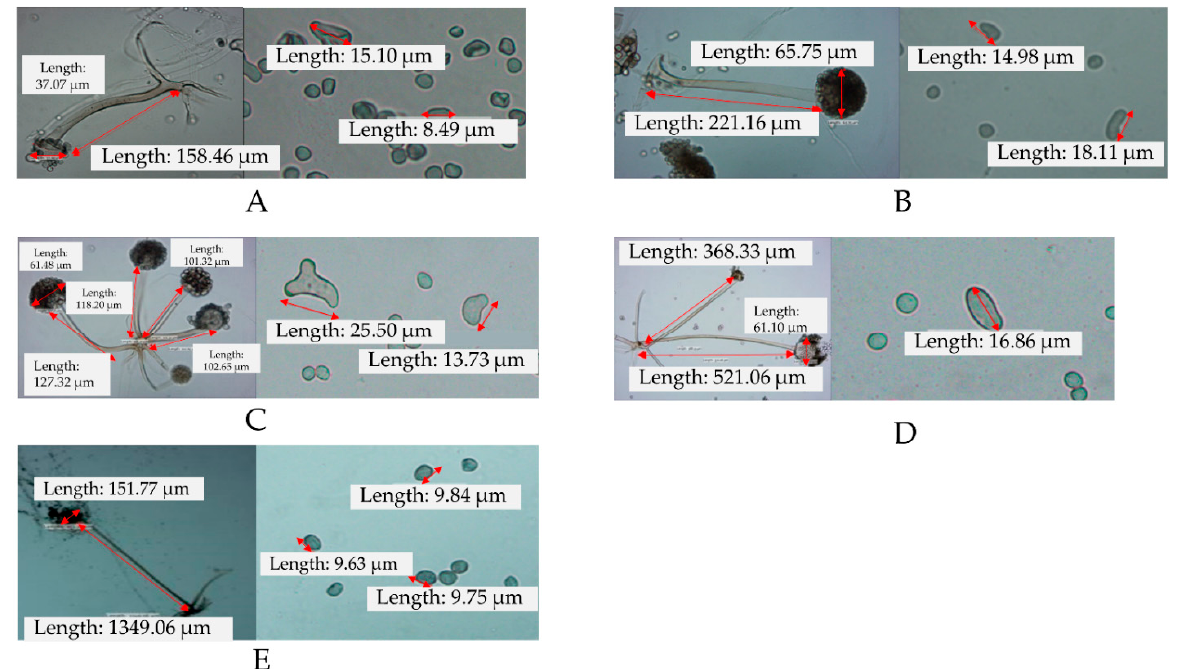
Figure 1. Sporangiophore, sporangium, columellae (left) and sporangiospore (right) of isolates Rhizopus oligosporus 1 ( A ), Rhizopus oligosporus 2 ( B ), Rhizopus oligosporus 3 ( C ), Rhizopus delemar ( D ) and Rhizopus oryzae ( E ). The pictures were taken at 400× magnification, except for R. oryzae , which was taken at 40× magnification. Table 1. Morphological identification of five local isolates of Rhizopus spp.